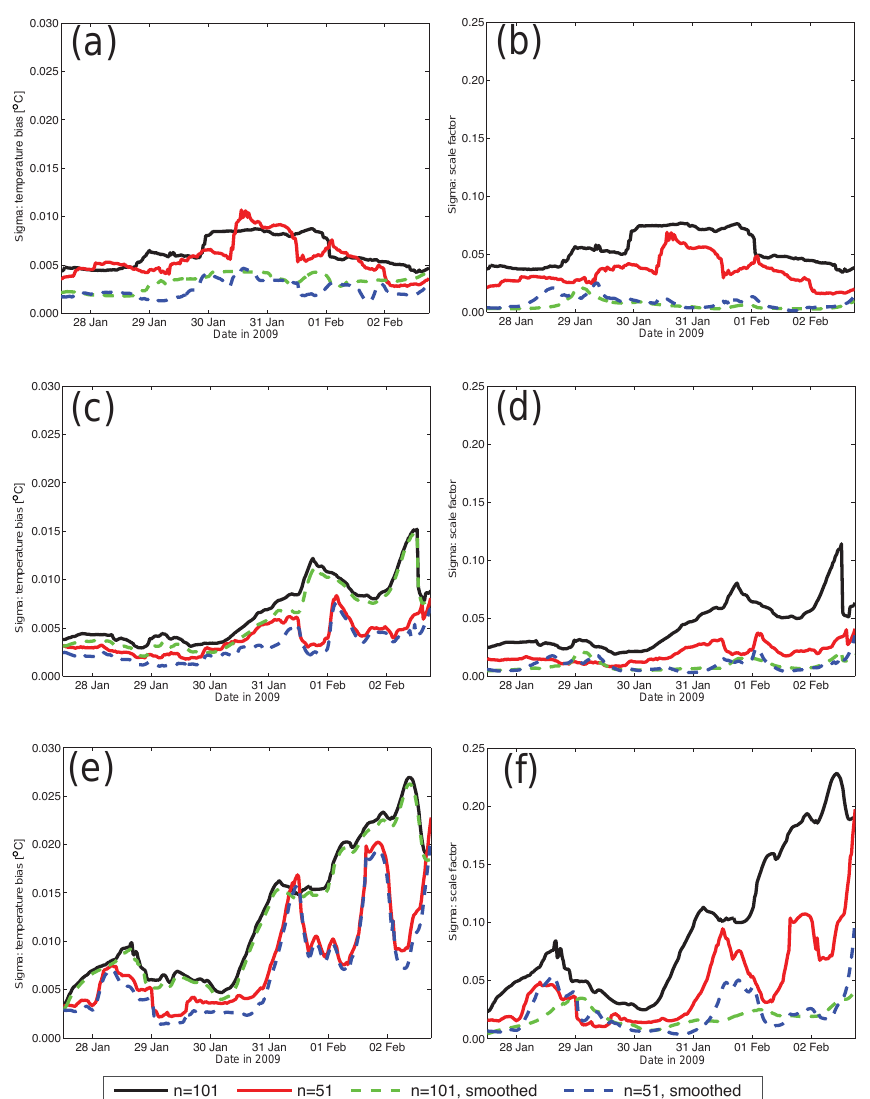
Figure 10. Epoch-wise standard deviations of biases (left panels) and scale factors (right panels) for the three pairs of loggers T1:T2 (top panels), T1:T3 (middle panels), and T1:T4 (bottom